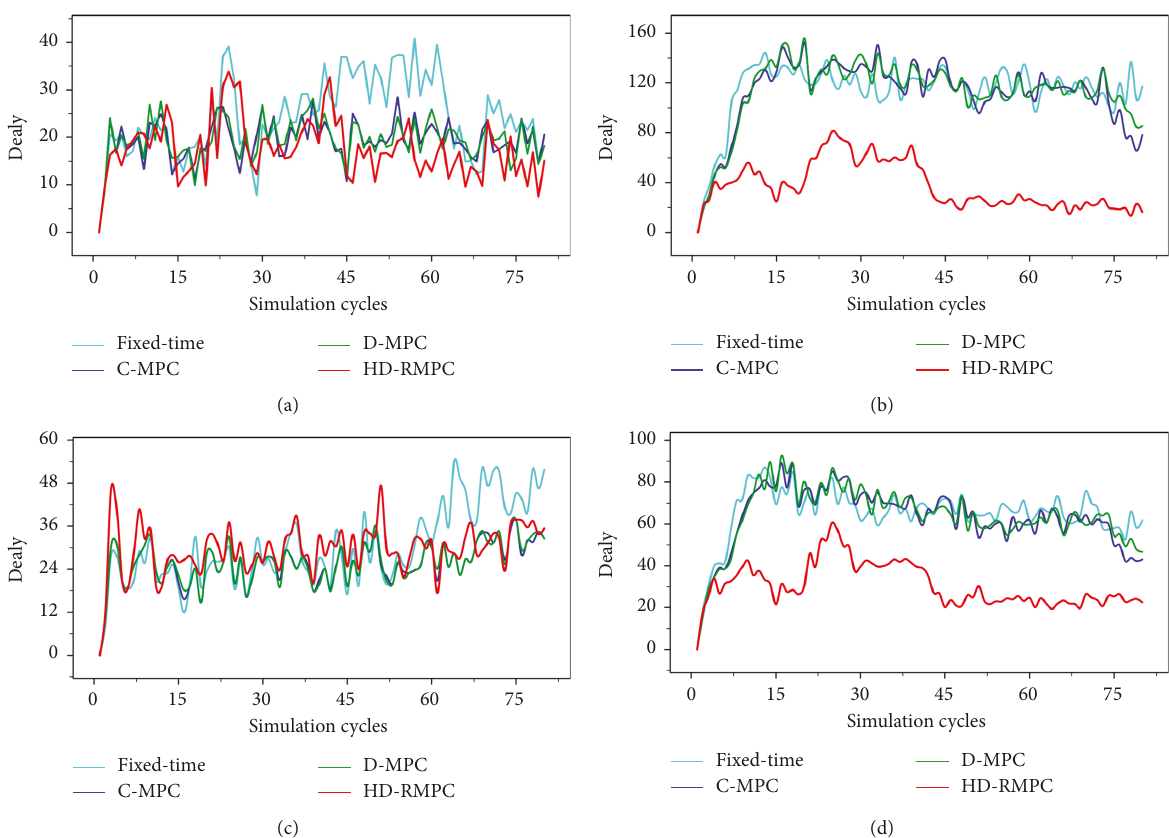
Figure 12: Average vehicle delay variation in each subarea during the simulation when N 2, and 3, respectively, and (d) shows the average value of the whole